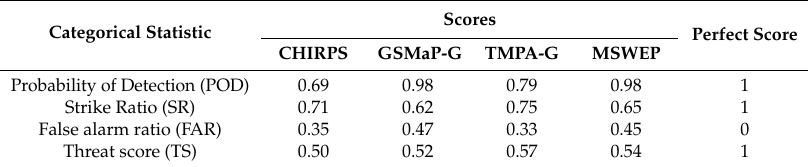
Table 3. Categorical statistics calculated for daily GSRP rainfall estimates relative to daily ground rainfall in the wet season throughout the study period